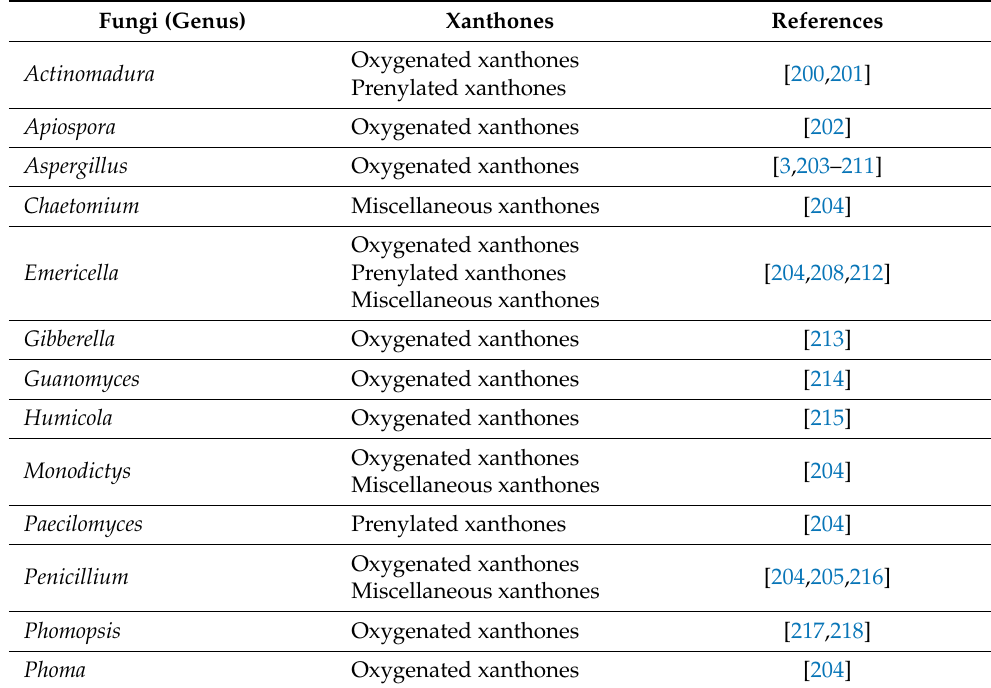
Table 2. Xanthones in Fungi. Fungi